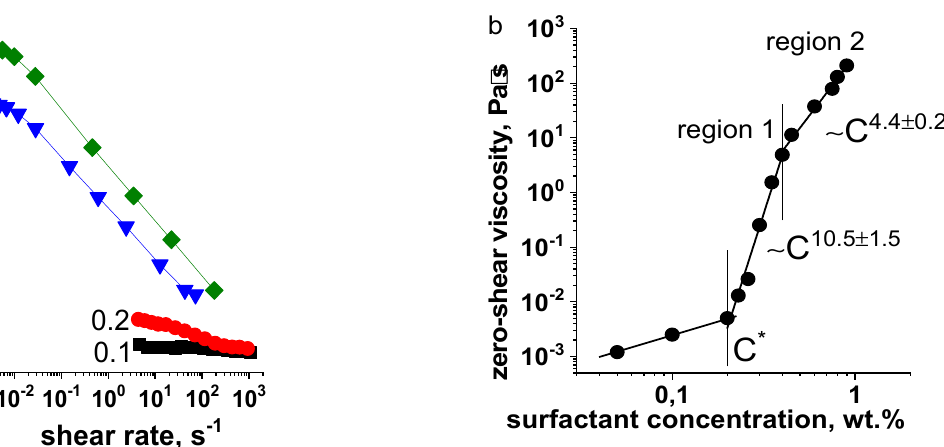
peak, meaning low electrostatic interaction between WLMs in the network in the presence of 1.5 wt.% KCl salt.